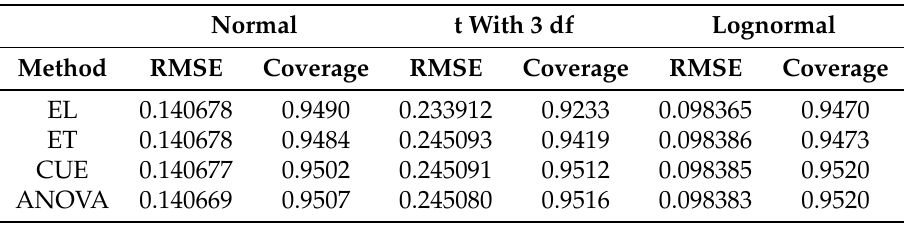
Table 1. Estimated root mean squared error and empirical coverage of nominal 95% confidence intervals (no